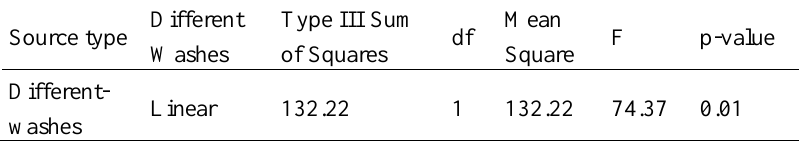
Statistical Analysis of Within-Subject of Mass loss at 7500 rubbing cycles